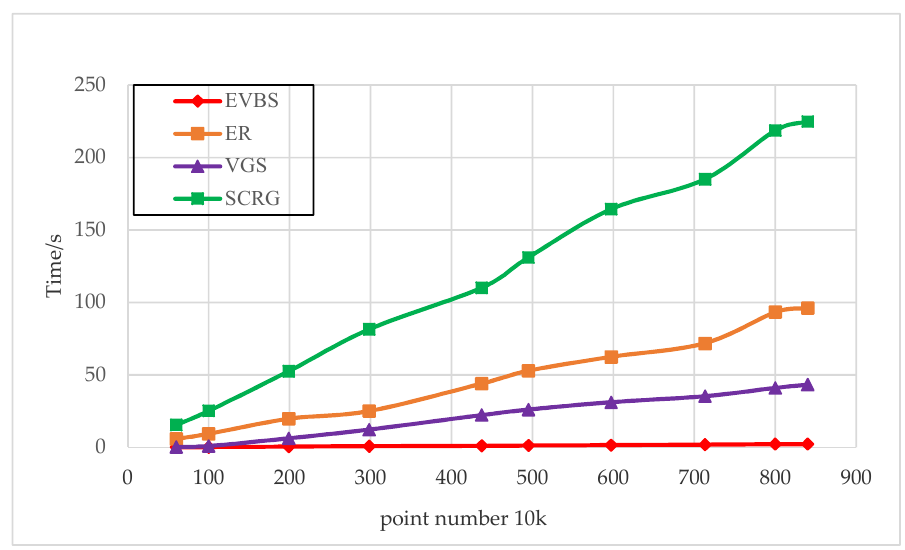
Figure 11. Execution time comparison of the three algorithms with different data sizes. Table 2. Plane segmentation evaluation results of experiments using terrestrial laser scanner